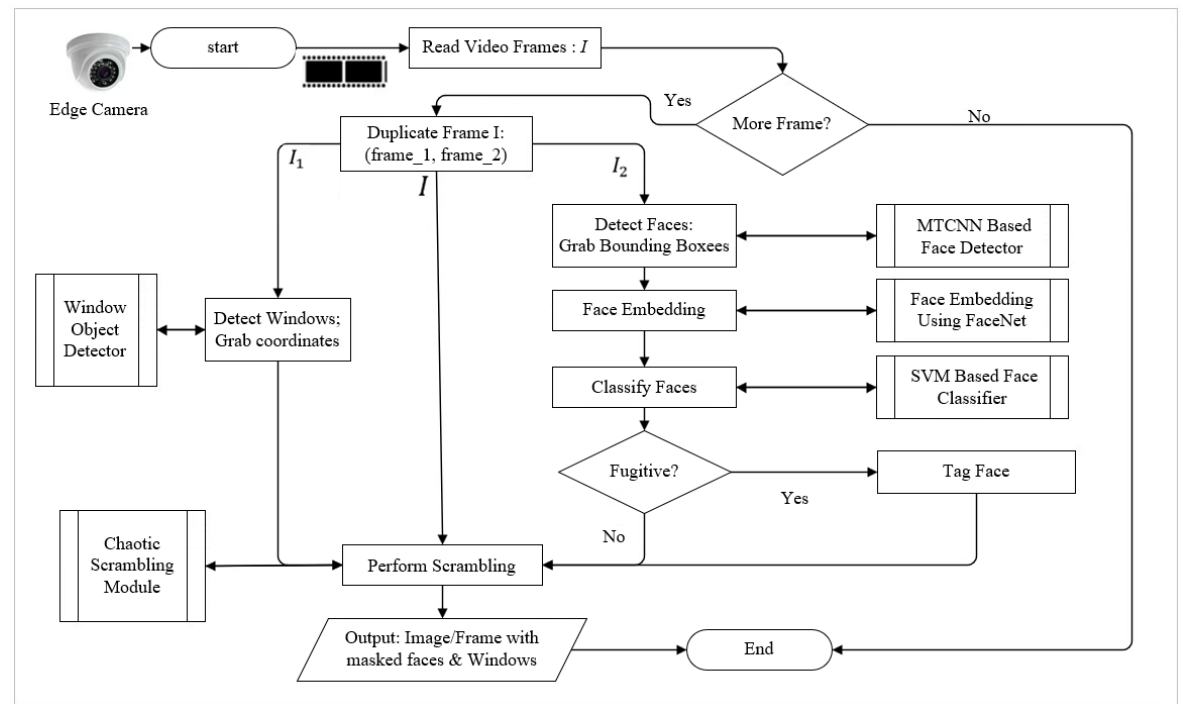
Figure 5. Window-and-face objects detection processes: At a server, following the decryption process, an incoming frame ( I = x ( t ) ) is duplicated into two more frames ( I 1 and I 2 ). I 1 & I 2 are utilized by the window-detector & face-detector modules, respectively, to output bounding boxes if there exist(s) any window(s) or face(s). The FaceNet is used for face embeddings which are then classified by an SVM model. The chaotic module scrambles the returned windows and faces.